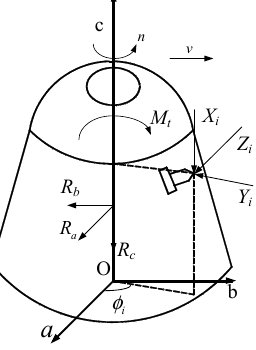
Figure 3. Force diagram of the cutting head. Table 1. The value of parameters in the load calculation formula.